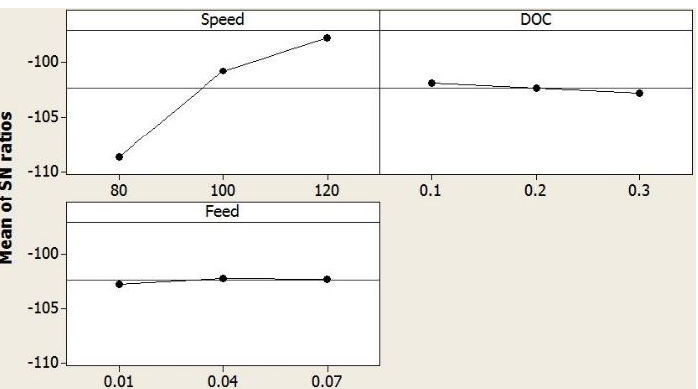
Figure 5: Signal-to-Noise analysis for parameters.